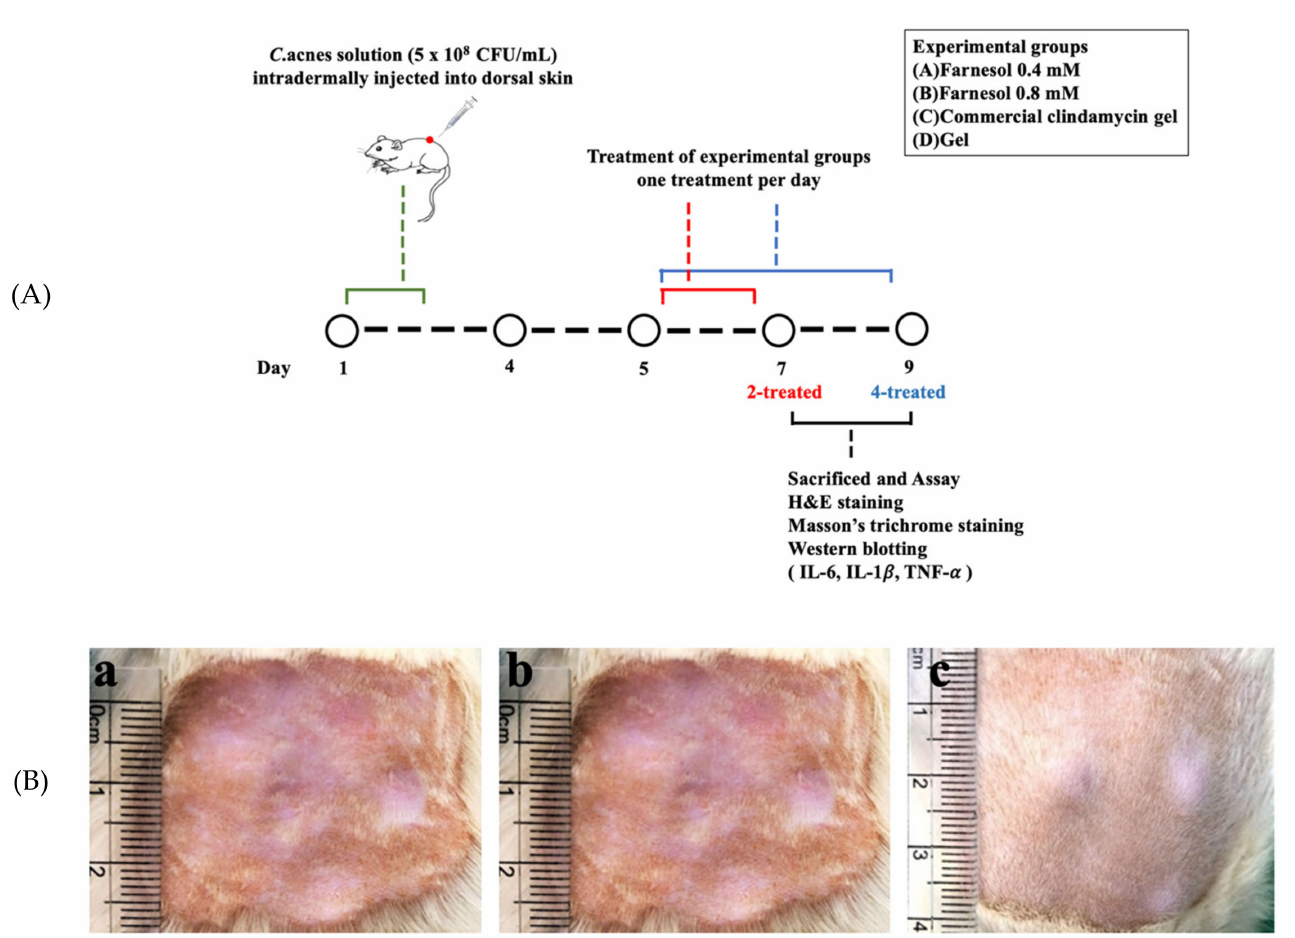
Figure 1. ( A ) Schematic of the development and the time scale of treatment of C. acnes -induced rat skin acne. ( B ) The dorsal skin of a rat injected with 5 × 10 8 CFU/mL C. acnes at 96 h postinjection ( a ), 144 h postinjection ( b ), and 192 h postinjection ( c